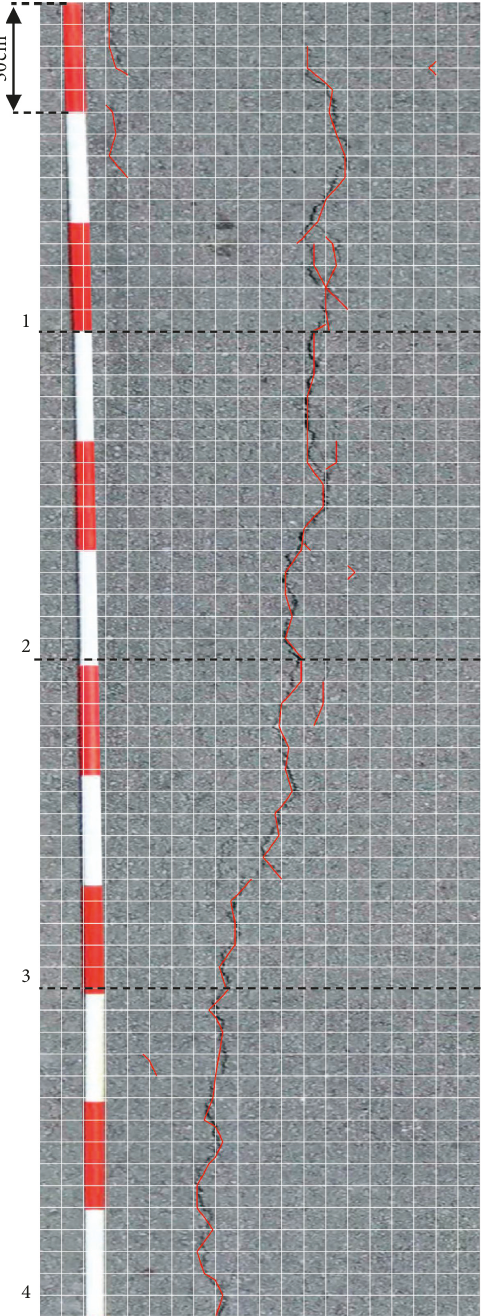
Figure 17: 4 processed frames with detected and mapped cracks. Mapping algorithm was able to separate all of 4 significant cracks and map